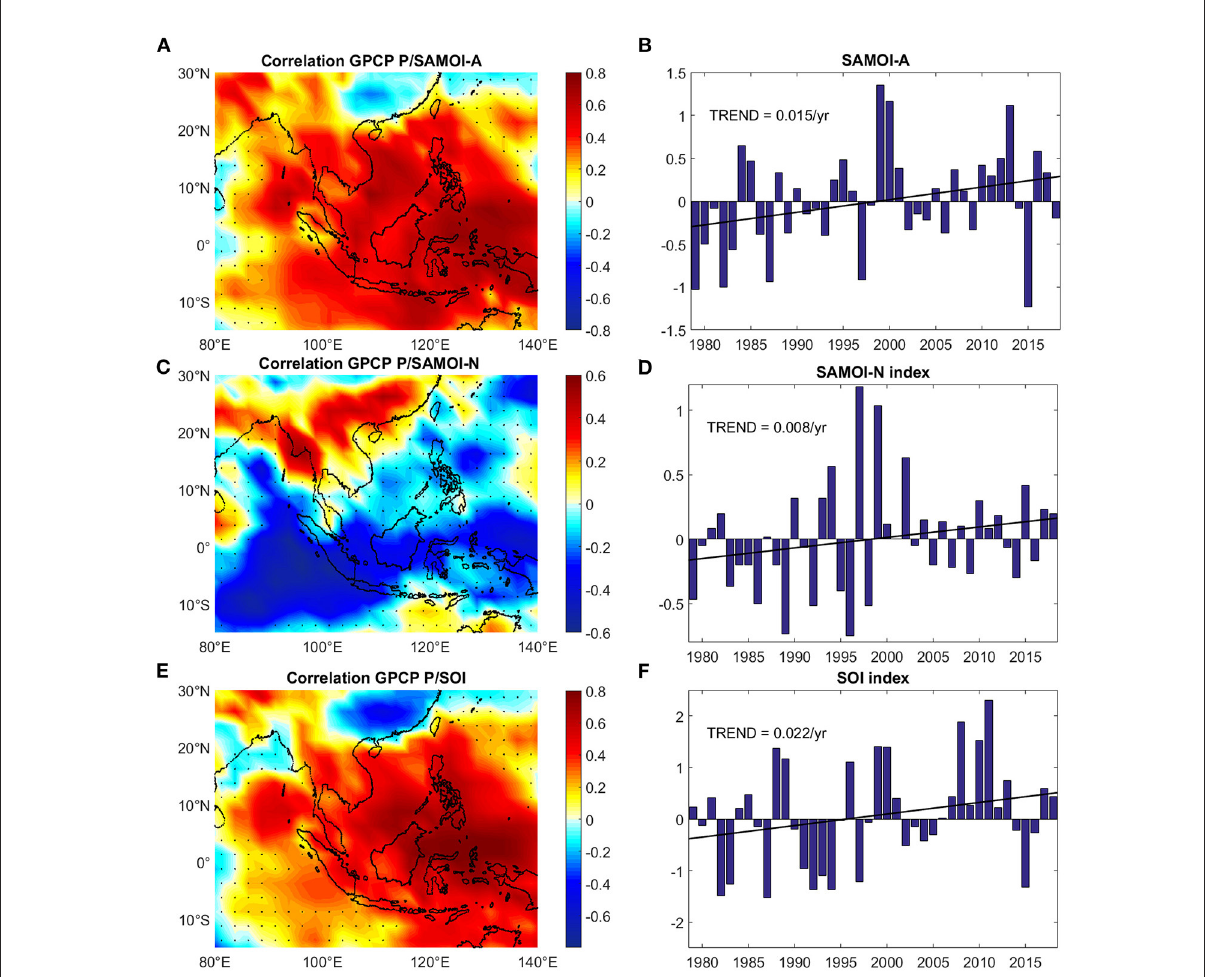
FIGURE12 Correlation spatial patterns between annual mean precipitation (GPCP) and SAMOI-A, SAMOI-N, and SOI index detrended timeseries (A,C,E) . Regions where the correlation is not significant at the 95% confidence interval are stippled. SAMOI-A, SAMOI-N, and SOI index annual timeseries over 1979–2018 (B,D,F) . Linear trends (significant at the 90% confidence interval) are also